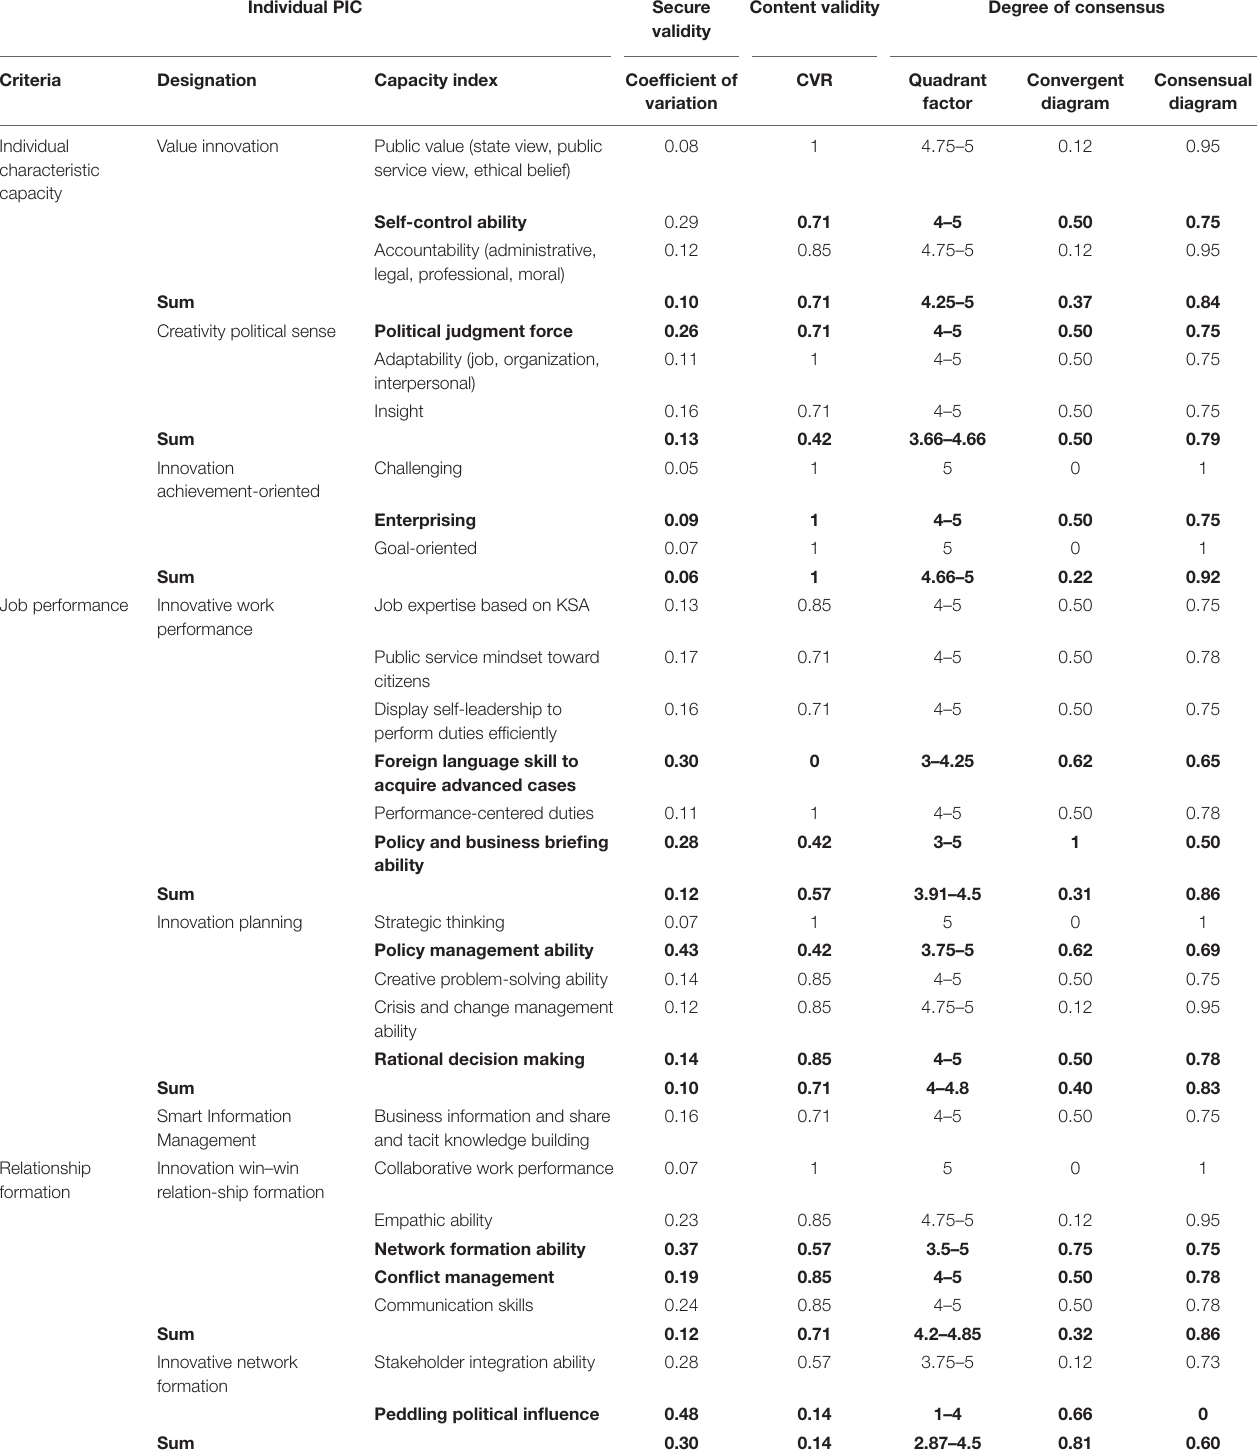
TABLE 2 | Results of Delphi Round